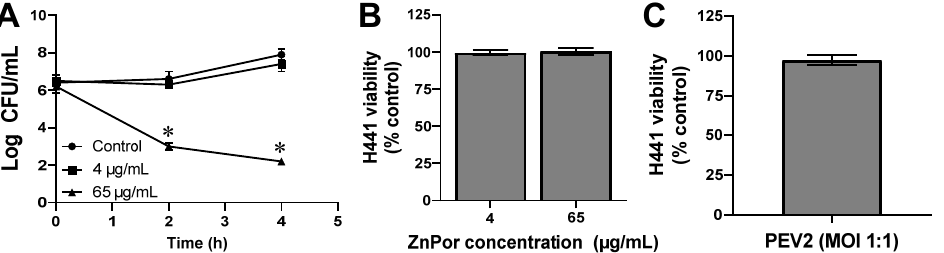
Figure 2. ZnPor concentration-dependent killing of PsA PAO1 cells and independent effects of ZnPor and PEV2 phage on the viability of H441 human lung cells. ( A ) Without photoactivation, 65 µ g/mL ZnPor killed PsA cells with greater than a 3-log reduction. At the MIC (4 µ g/mL), no change to PAO1 levels were identified ( B ) H441 cell viability was not significantly reduced by ZnPor at either 4 or 65 µg/mL following a 24 h exposure. ( C ) H441 cell viability was una ff ected by the addition of a PEV2 phage at an MOI of 1:1 following 24 h exposure. Neither ZnPor nor PEV2 displays any statistically signi fi cant toxicity against H441 lung cells. * indicates statistical signi fi cance from untreated control ( p < 0.05, n = 3).